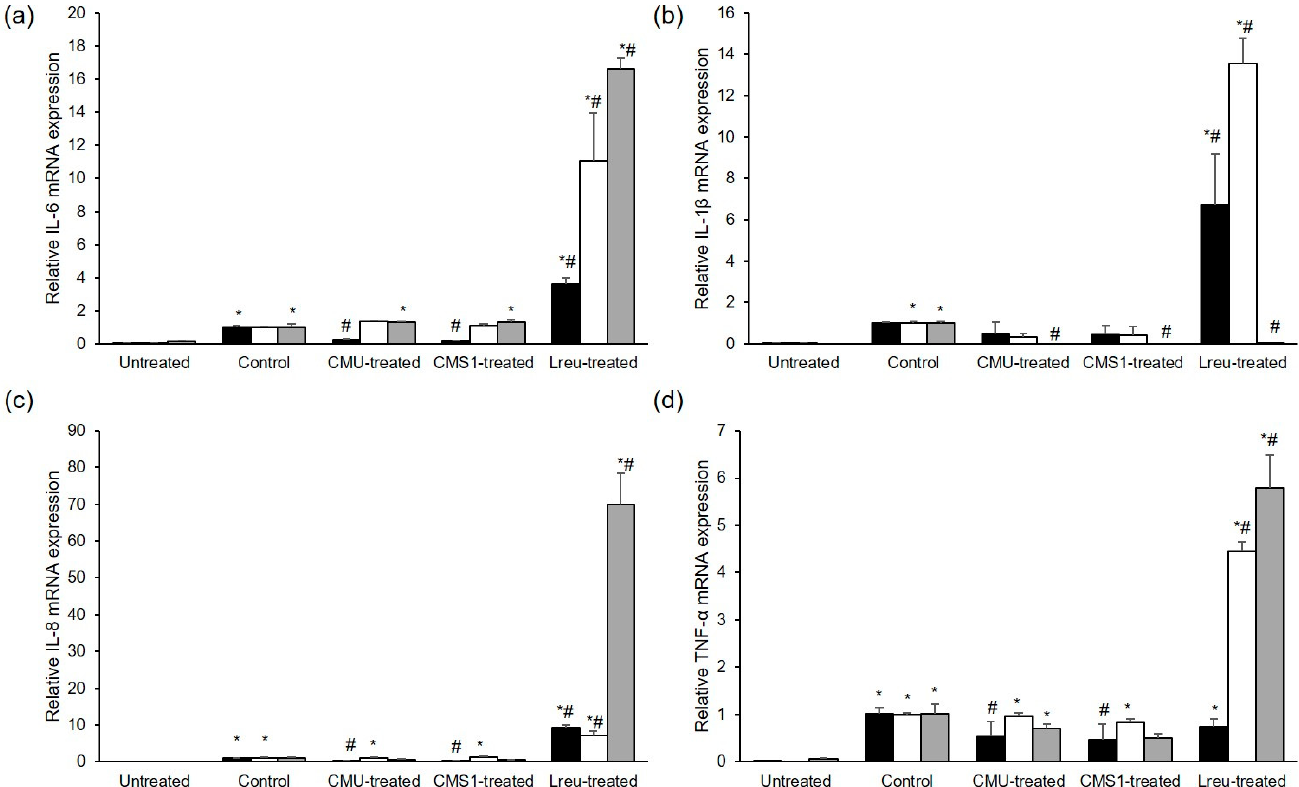
Figure 4. Comparison of the effects of oral probiotics on pro-inflammatory cytokine gene expression, including IL-6 ( a ), IL-1 β ( b ), IL-8 ( c ), and TNF- α ( d ), stimulated by periodontopathogens. Black bar, P. gingivalis ; white bar, F. nucleatum ; gray bar, P. intermedia; CMU, W. cibaria CMU; CMS1, W. cibaria CMS1; Lreu, L. reuteri . Data are presented as the mean ± standard deviation. * p < 0.05, compared to the untreated group. # p < 0.05, compared to the control group.